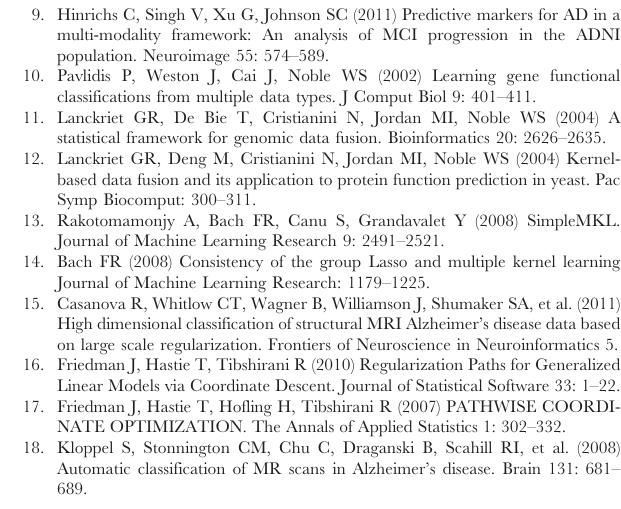
Figure S1. The CV procedure with nested 10 fold CV is